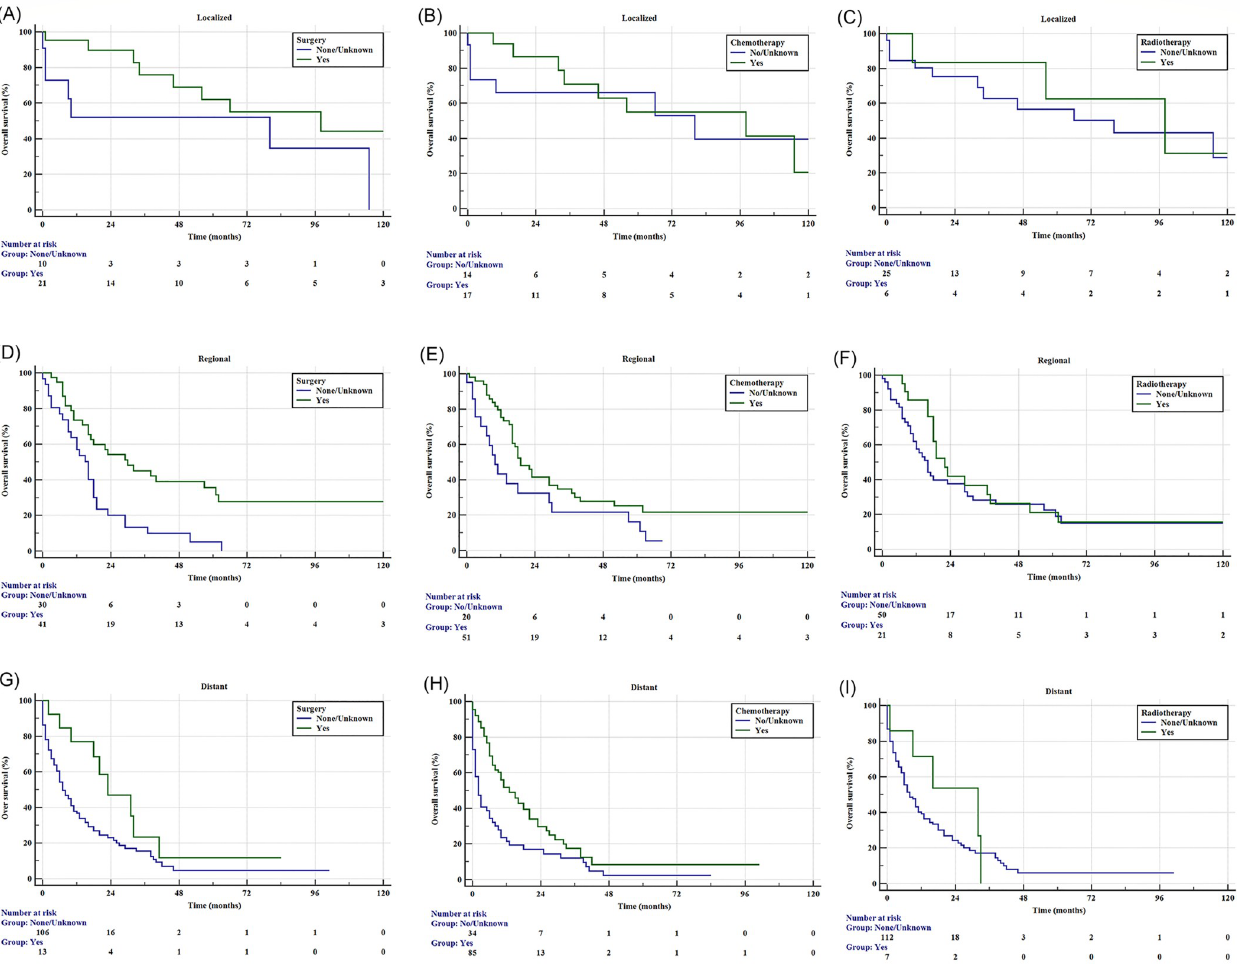
Fig 3. Kaplan–Meier estimated overall survival for patients with pancreatic acinar cell carcinoma based on the summary stage. (A-C): based on localized stage, A:surgery (p = 0.053), B: chemotherapy (p = 0.609), and C: radiotherapy (p = 0.729), (D-F): based on regional stage, D:surgery (p < 0.001), E: chemotherapy (p = 0.041), F: radiotherapy (p = 0.369) (G-I) based on distant stage:G: surgery (p = 0.031), H: chemotherapy (p < 0.001), I: radiotherapy (p = 0.365).